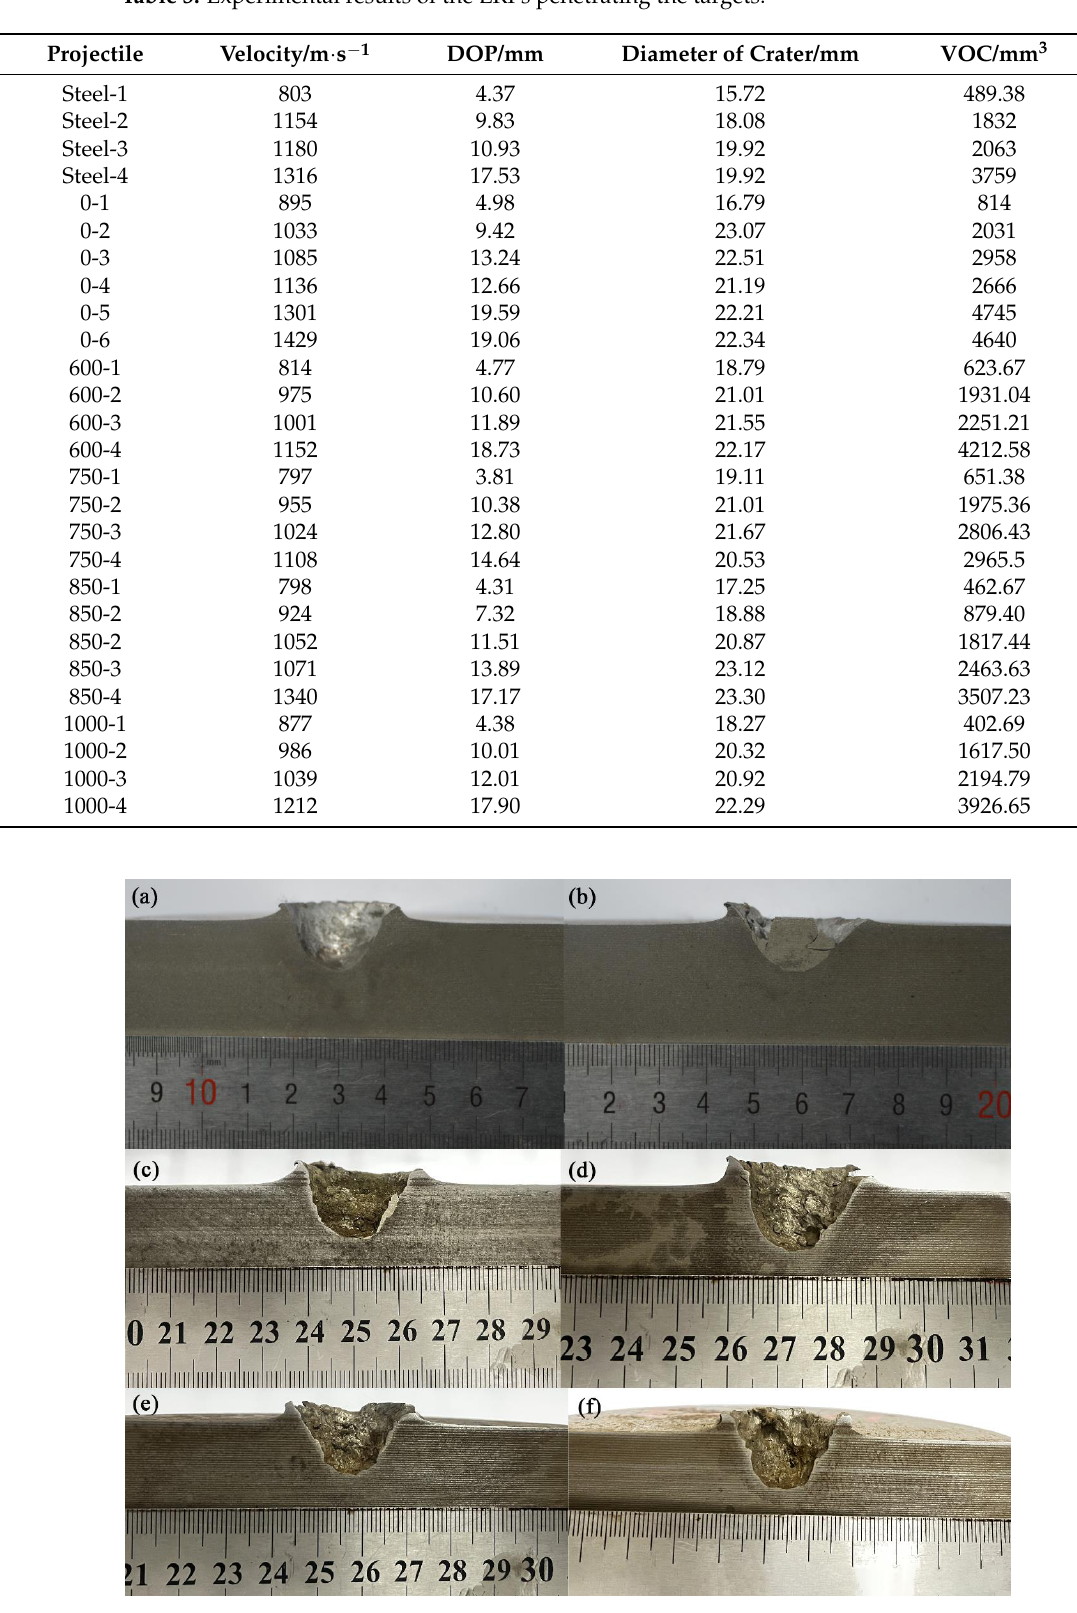
Figure 14. The effects of the projectile hitting the target: ( a ) Steel, 1154 m/s, the FeNiCoCr HEA annealed at ( b ) Initial, 1033 m/s, ( c ) 600 °C, 1001 m/s, ( d ) 750 °C, 1024 m/s, ( e ) 850 °C, 1052 m/s and ( f ) 1000 °C, 1039 m/s.